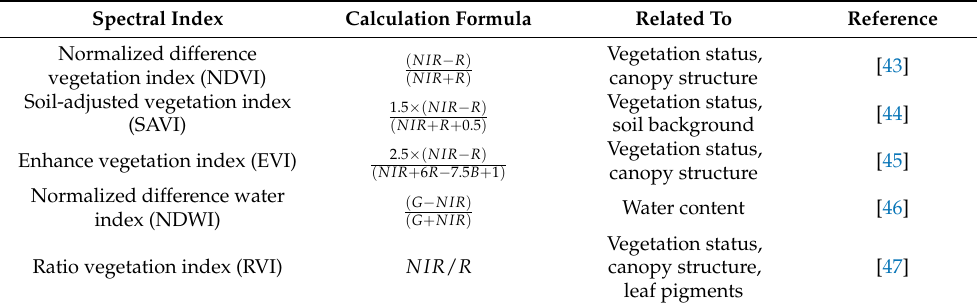
Table 2. Vegetation indices (VIs) were used for the identification of abandoned jujube fields in this